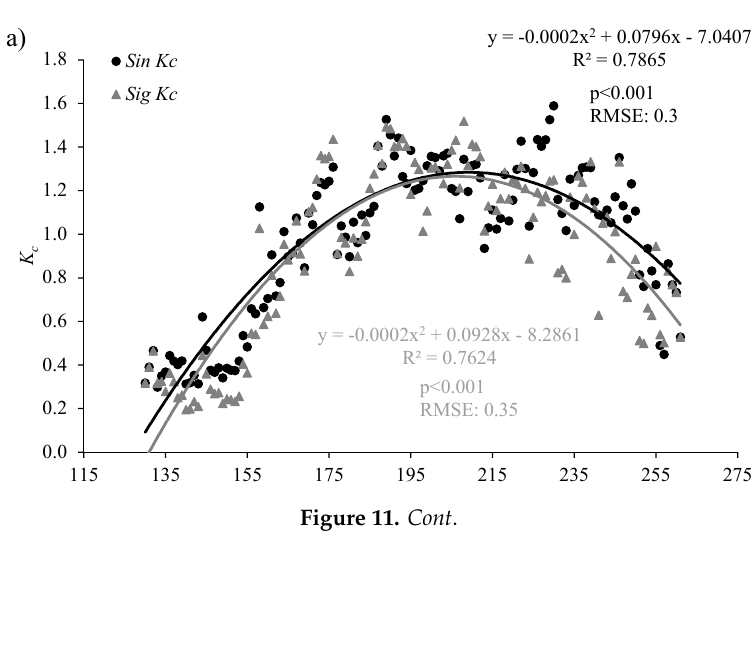
Figure 11. ( a , b ) Seasonal variation in reference evapotranspiration ( ET 0 ) based on crop coefficients ( K c ) for two soybean varieties, Sinara ( Sin ) and Sigalia ( Sig ), during 2017 (a) and 2018 (b) at Keszthely, Hungary. The warm spring in 2018 (end of April to the beginning of May) increased initial K c values slightly. Irrespective of the season, the measured daily K c values were characterized by rapid increases from early June to about mid-August, followed by a steady decrease due to reduced LAI , solar radiation and ETR towards September. This pattern is evident for variation in daily K c , although the coefficients varied in each season (Table 4). Table 4. The monthly mean crop coefficient ( K c ) for three developmental stages (V: vegetative growth; R 1– R 6: from the start of bloom to full seed; R 7– R 8: from the start of maturity to full maturity) based on Fehr and Caviness (1977) [27]. Abbreviations: Sinara : Sin ; Sigalia : Sig ; WW : no limited water supply.